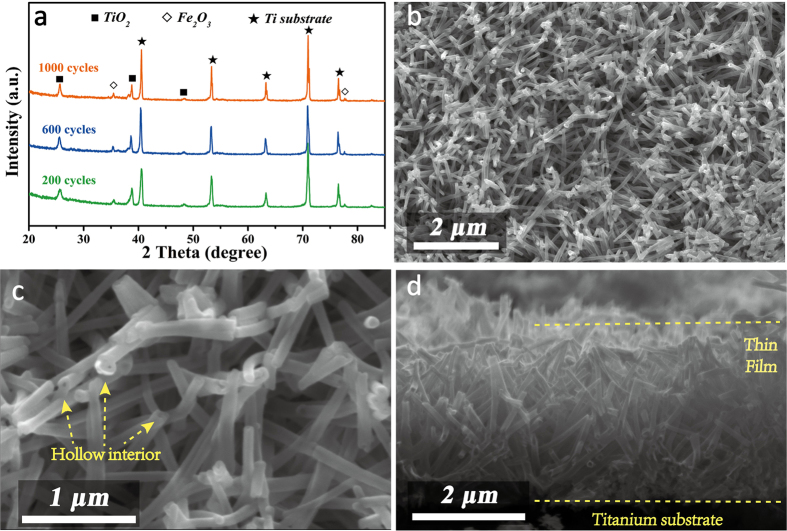
(a) XRD patterns of TiO2@Fe2O3 nanotube arrays with different coating loops. (b,c) SEM images of representative TiO2@Fe2O3-600 sample and (d) the cross-section. Hollow interior construction can be detected in (c).